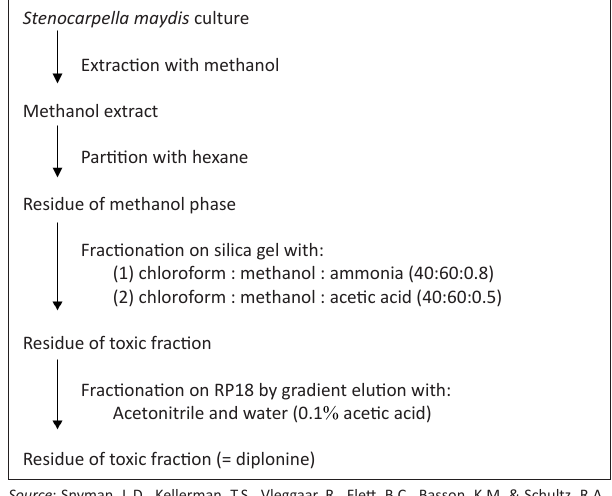
FIGURE 2: Schematic representation of the original isolation of diplonine.